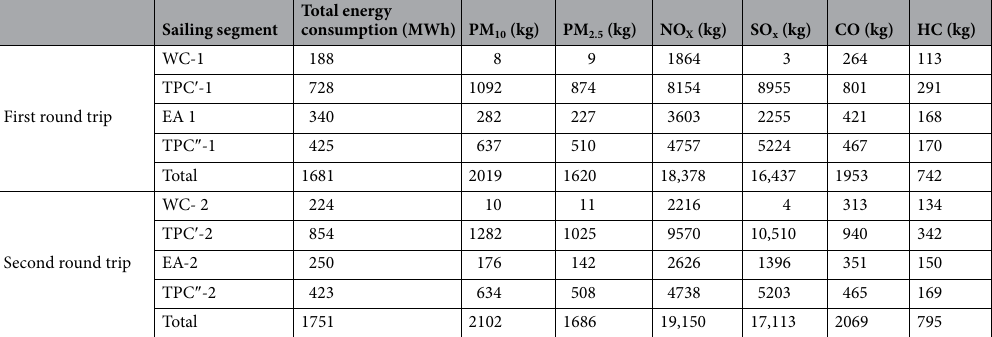
Table 1. Total energy consumption and total air pollution emissions of each sailing